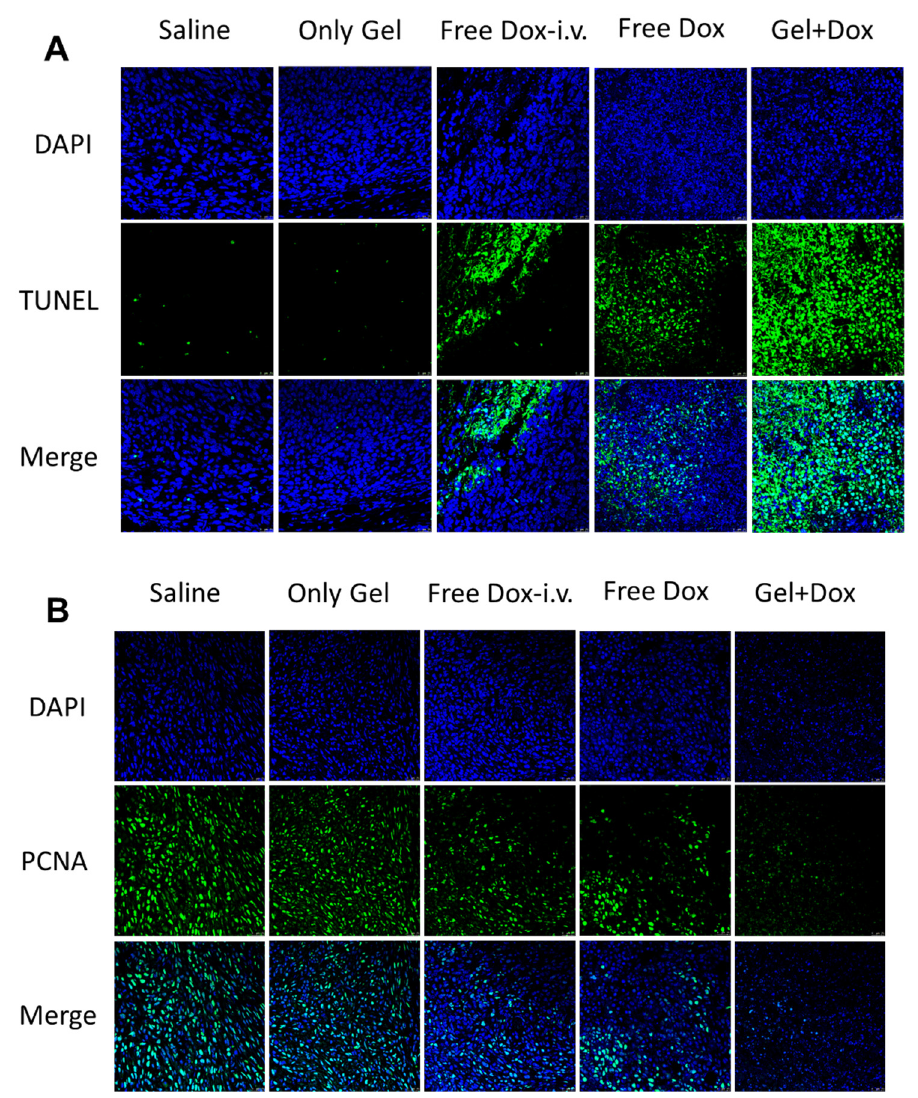
Figure 6. ( A ) Photographs of the TUNEL-stained fluorescent microscopy of different tumor slices; ( B ) photographs of the PCNA-stained fluorescent microscopy of different tumor slices.